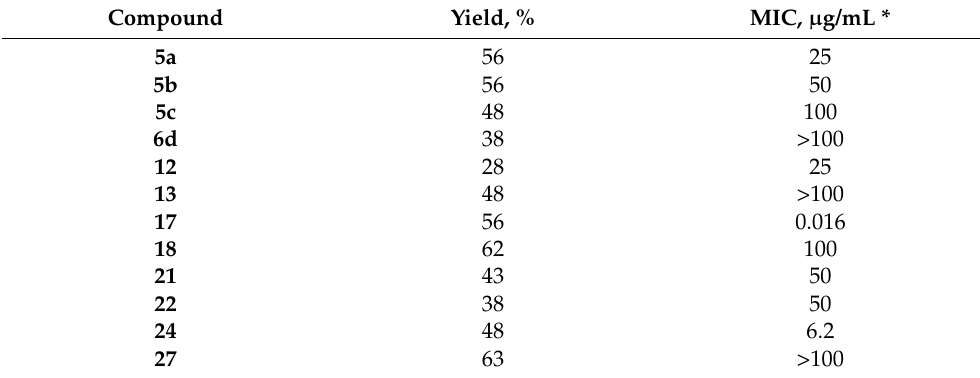
Table 1. Yields and growth inhibitory activity of 5-nitrofuroyl derivatives against drug-sensitive M. tuberculosis H37Rv